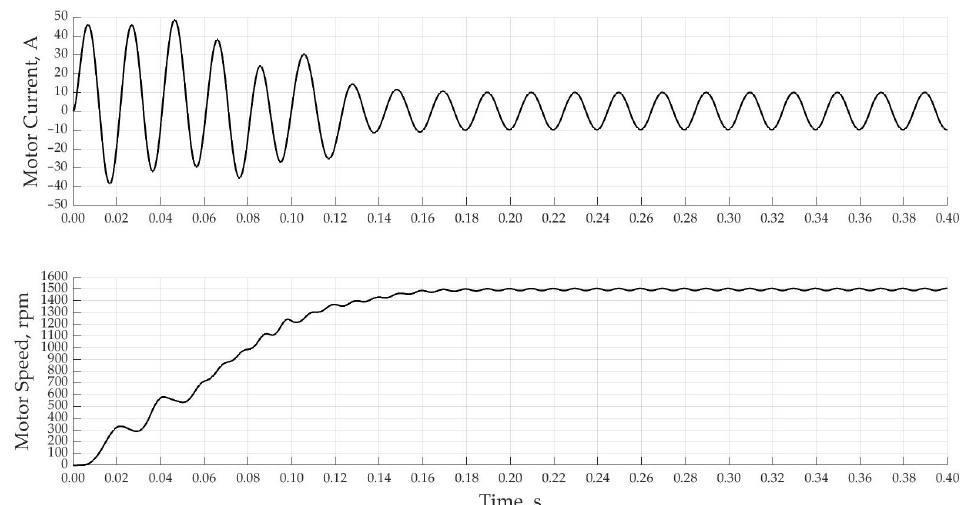
Figure 10. Starting current and motor speed under direct start.